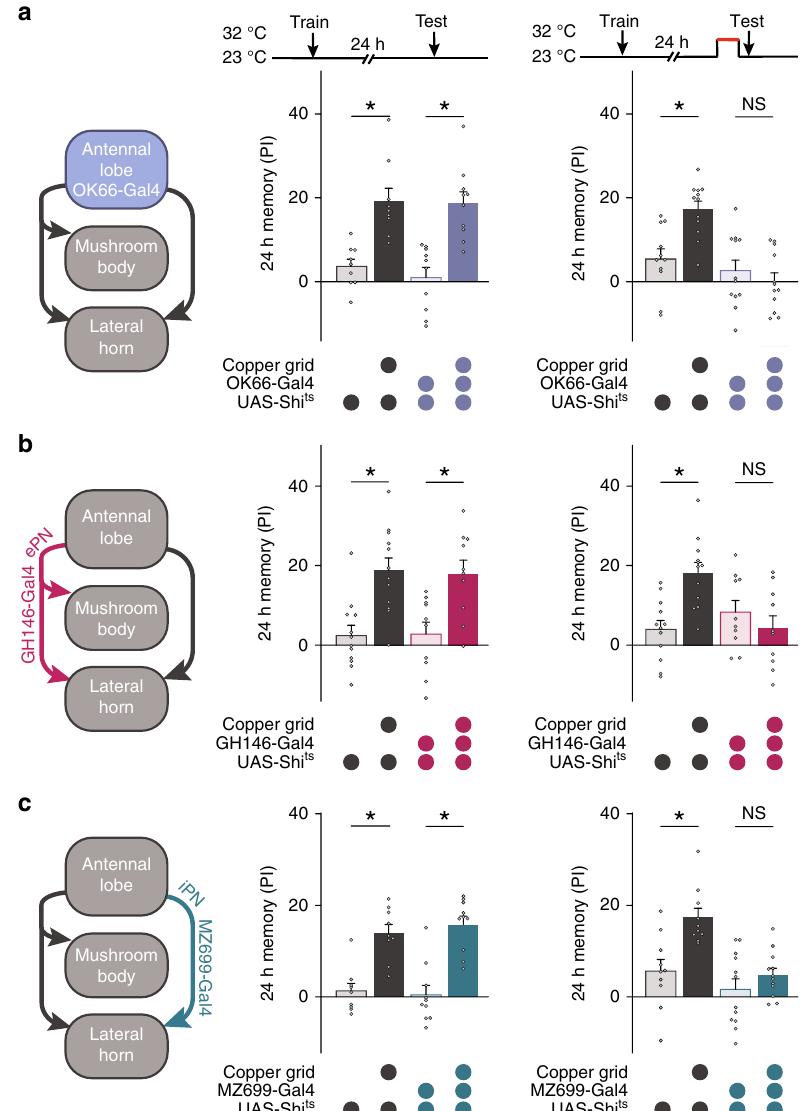
Fig. 3 Retrieval of cLTM requires the antennal lobe and projection neurons. a Left: Schematic of OK66-Gal4 antennal lobe (AL)-local neurons. Right: Blockade of OK66 neurons during testing abolishes cLTM retrieval ( n = 9 – 12). b Left: Schematic of GH146-Gal4 excitatory projection neurons (ePNs). Right: blockade of GH146 neurons during testing abolishes cLTM retrieval ( n = 10 – 12). c Left: Schematic of MZ699-Gal4 inhibitory projection neurons (iPNs). Right: Blockade of MZ699 neurons during testing abolishes cLTM retrieval ( n = 9 – 12). Data are mean performance indices ± SEM; individual data points are displayed as dots; * P < 0.05 by ANOVA or t